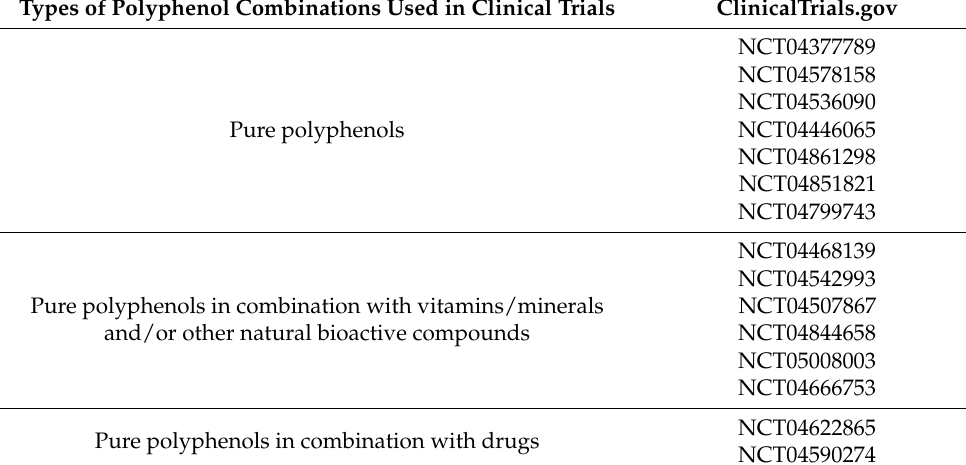
Table 1. Clinical trials investigating the effects of polyphenols in prophylaxis and the treatment of